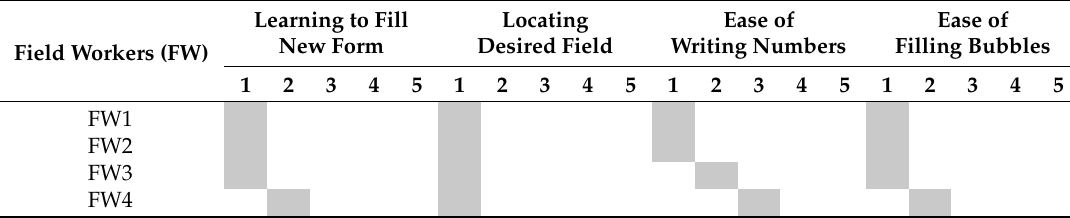
Table 3. Self-administered questionnaire items.